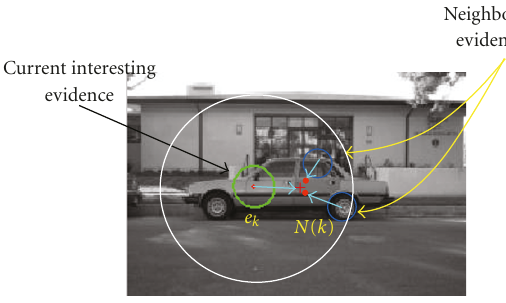
Figure 22: Concept of part-part context. The quality of current interesting evidence is determined by neighboring